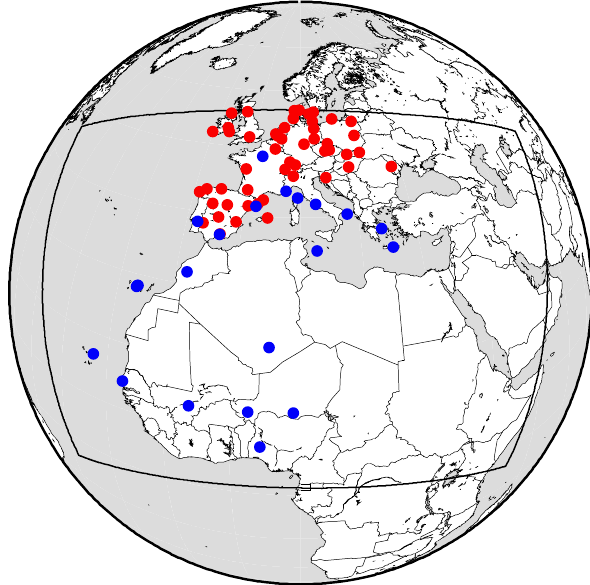
Figure 1. Locations of the measurements stations used in this study; in red are the EMEP stations and in blue are the AERONET stations. Names and coordinates of these stations are listed in Table 1 and Table